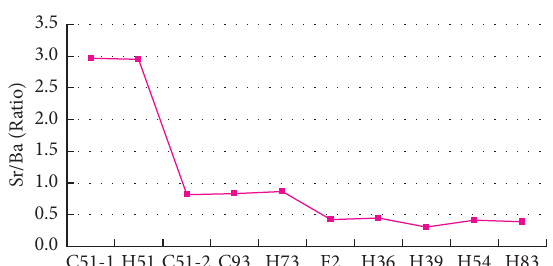
Figure 3: Changes in the Sr/Ba ratio of the Chang 8 reservoir of the Yanchang formation in the study